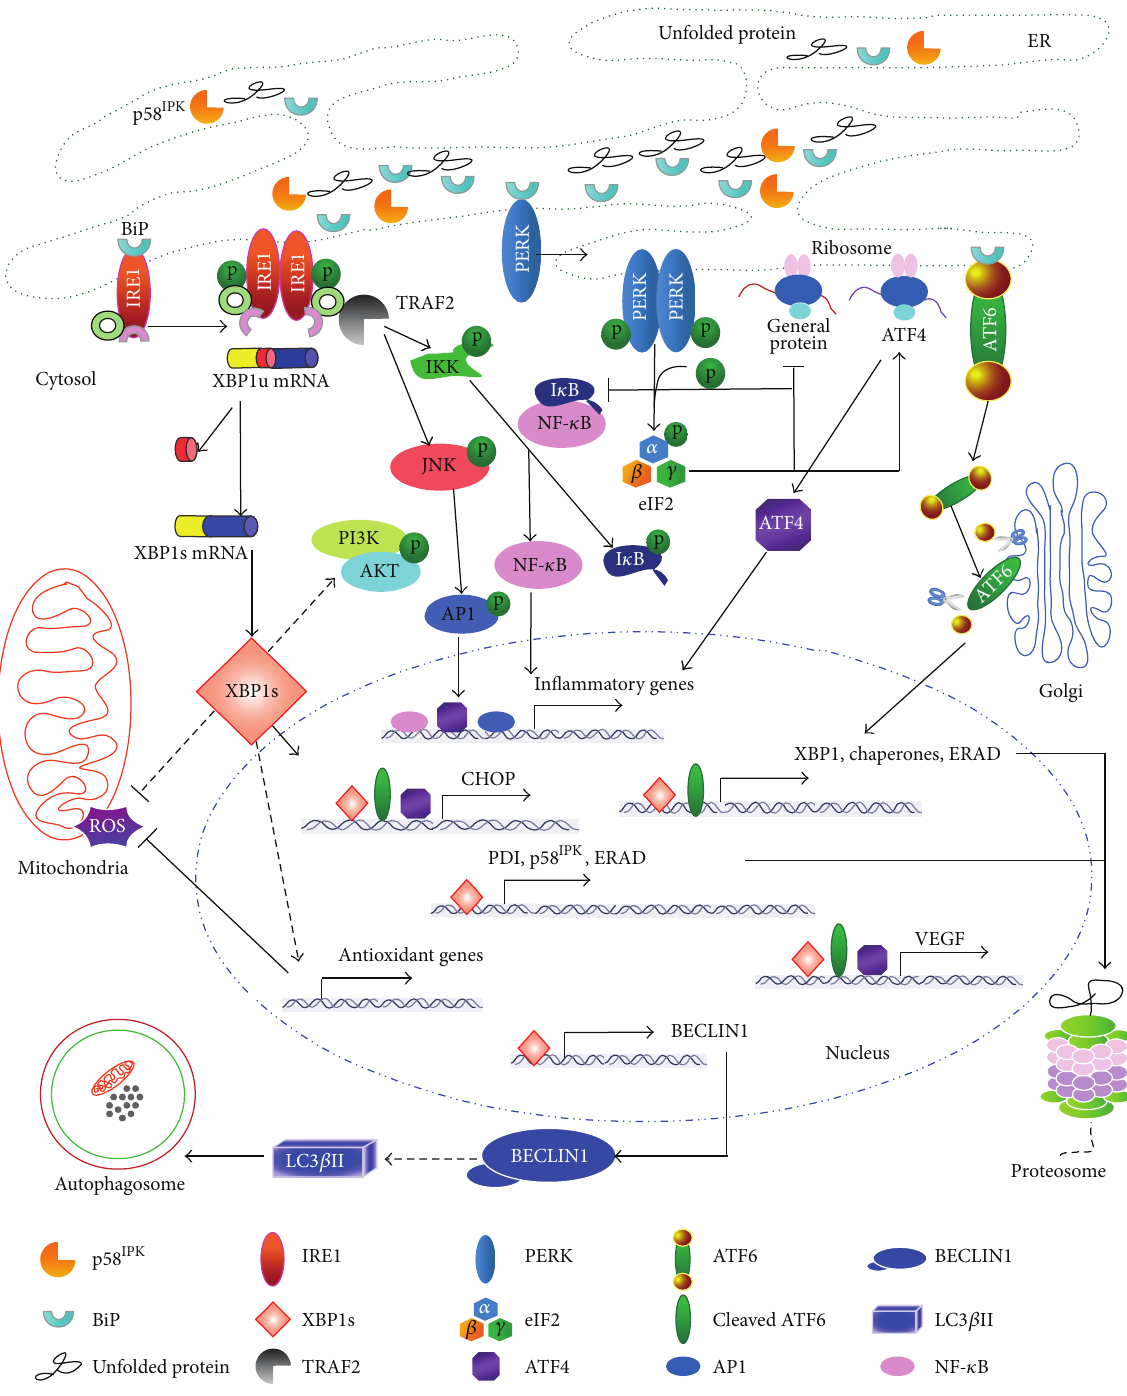
Figure 1: UPR signaling pathways in retinal cell physiology. Three ER stress sensors PERK, IRE1, and ATF6 are activated when unfolded proteinstethertheERchaperoneBiP/GRP78awayfromthesensors.Uponactivation,IRE1autophosphorylatesandformsadimeroroligomer that mediates the unconventional splicing of XBP1 mRNA. This process generates the active transcription factor XBP1s that regulates genes involvedinER-associatedproteindegradation(ERAD),autophagy,ERqualitycontrol,andredoxhomeostasis.ActivatedIRE1recruitsTRAF2 and induces activation of JNK and NF- 𝜅 B leading to increase transcription of inflammatory genes. Once removed from BiP/GRP78, AFT6 moves to the Golgi where it is cleaved by local site 1 and site 2 protease. The cleaved ATF6 is a transcription factor that regulates a subset of componentsforERADandERchaperones.LikeIRE1,PERKisactivatedbyautophosphorylationandphosphorylatesthetranslationinitiation factor eIF2 𝛼 , which suppresses the general translation but selectively increases the translation of ATF4. ATF4 subsequently upregulates the proapoptotic gene CHOP and also modulates the transcription of a variety of genes in inflammation, oxidative stress, apoptosis, and stress